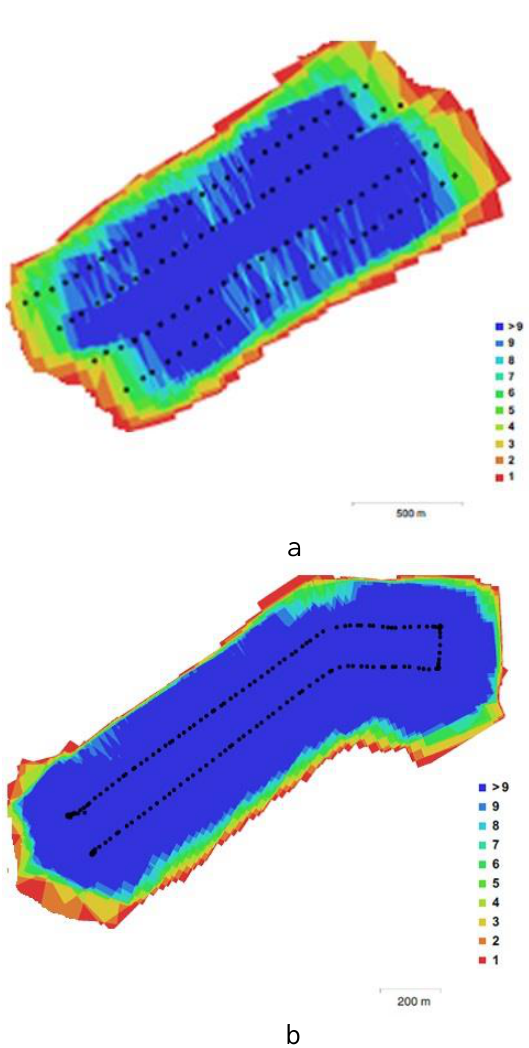
Figure 5. Camera positions and image overlaps. (a) fixed-wing (b) multi-rotor. The legend on the right represents the number of images in which a point appears.